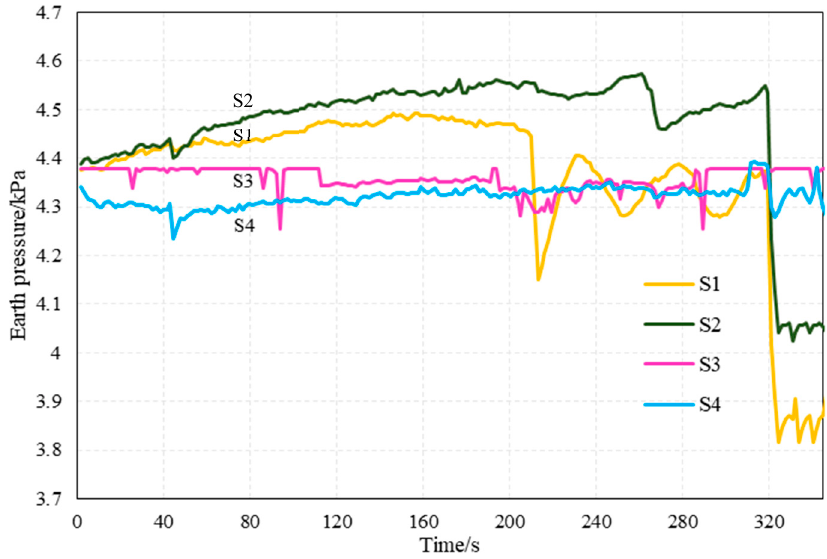
Figure 18. Measured soil pressure for Model 13-5.